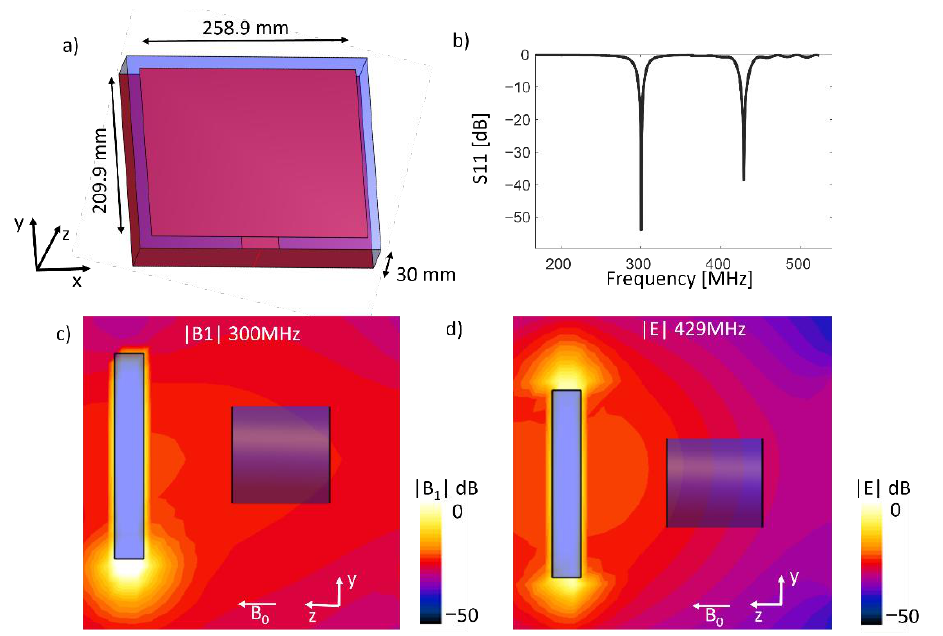
Figure 1. Design of ( a ) a patch antenna without size reduction, ( b ) S 11 parameters of the antenna showing dual frequency, ( c ) the |B 1 |-field of the antenna at 300 MHz and ( d ) the |E|-field at 429 MHz.